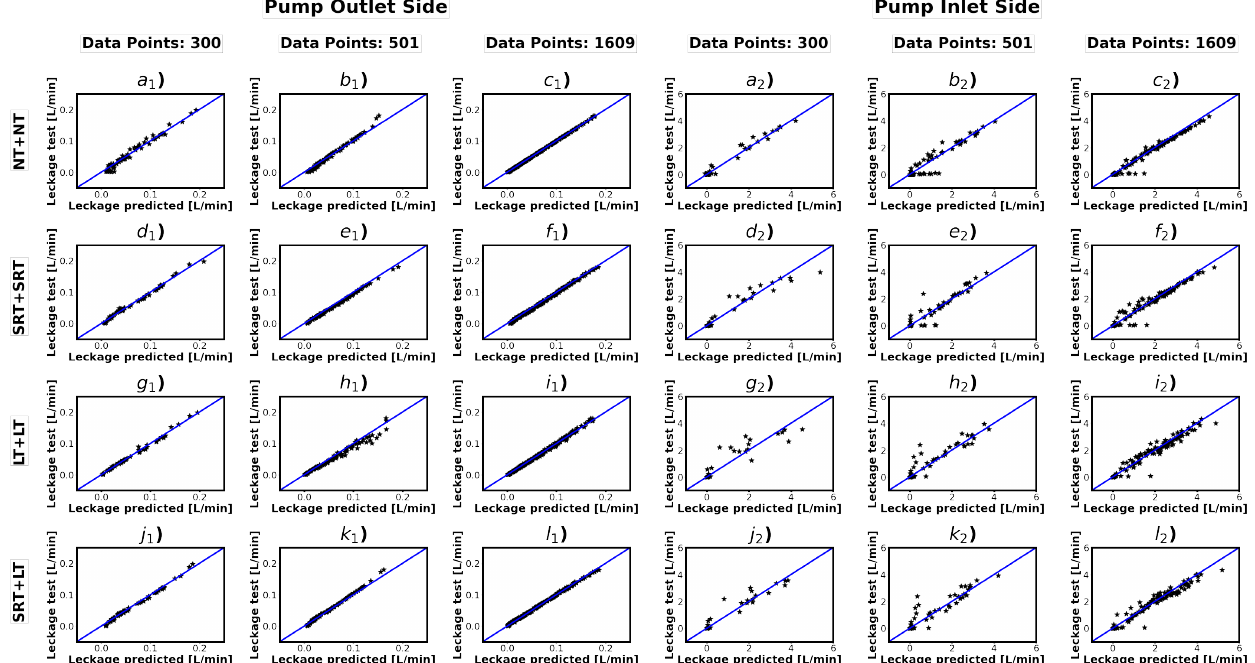
Figure 7. Neural Network Test Results Visualization. ( a 1 , 2 ) Model: 300 data points without trans- formation on both sides of the pump. ( b 1 , 2 ) Model: 501 data points without transformation on both sides of the pump. ( c 1 , 2 ) Model: 1609 data points without transformation on both sides of the pump. ( d 1 , 2 ) Model: 300 data points using SRT on both sides of the pump. ( e 1 , 2 ) Model: 501 data point susing SRT on both sides of the pump. ( f 1 , 2 ) Model: 1609 data points using SRT on both sides of the pump. ( g 1 , 2 ) Model: 300 data points using LT on both sides of the pump. ( h 1 , 2 ) Model: 501 data point susing LT on both sides of the pump. ( i 1 , 2 ) Model: 1609 data points using LT on both sides of the pump. ( j 1 , 2 ) Model: 300 data points using SRT on data of pump’s outlet side and LT on data of pump’s inlet side. ( k 1 , 2 ) Model: 501 data points using SRT on data of pump’s outlet side and LT on data of pump’s inlet side. ( l 1 , 2 ) Model: 1609 data points using SRT on data of pump’s outlet side and LT on data of pump’s inlet